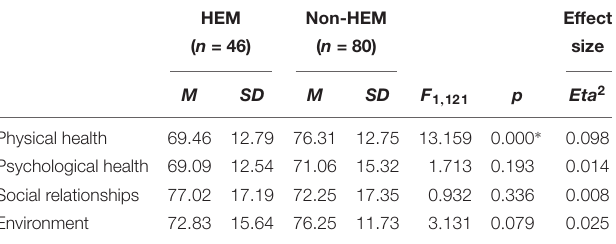
TABLE 3 | Comparisons of the four WHOQOL-BREF dimensions between music students (HEM) and amateur musicians (non-HEM). HEM Non-HEM Effect